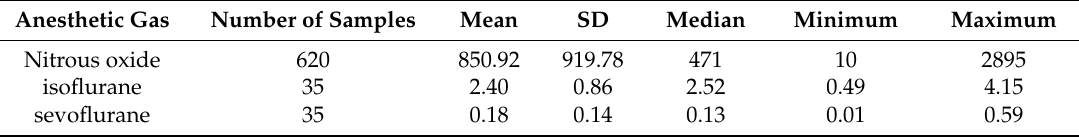
Table 2. Mean air concentration of anesthetic gases (ppm) for exposed individuals. Anesthetic